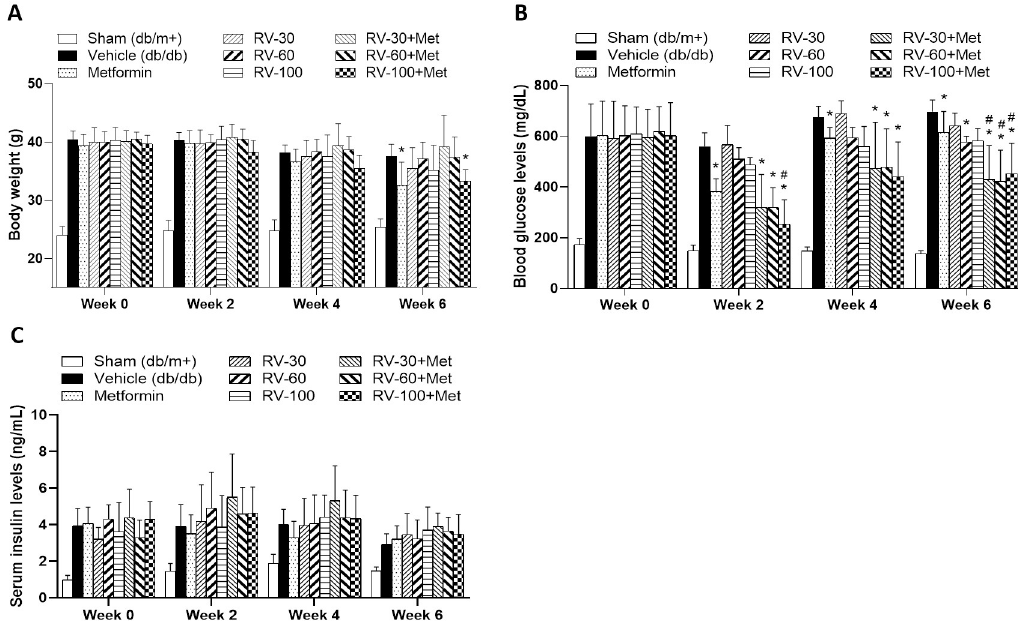
Fig 8. Effects of RV-mono and RVM-combination treatments in db / db mice. (A) The RV-100+Met and metformin groups displayed significant body weight reduction relative to the vehicle group ( � P < 0.05; two-way ANOVA). (B) The RVM- combination treatment had significant glucose-lowering efficacy compared to the vehicle ( � P < 0.05, two-way ANOVA) and the metformin treatment ( # P < 0.05, two-way ANOVA). (C) The serum insulin levels in the RVM-combination group were slightly higher than those in the metformin and RV-mono groups. N = 8 per group. Statistical analysis was performed using two-way